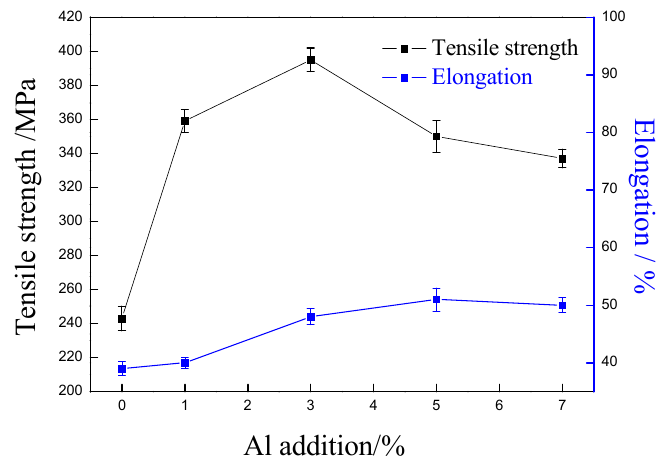
Figure 7. Effects of Al content on tensile strength and elongtion of Cu-7Ni- x Al-1Fe-1Mn alloy.